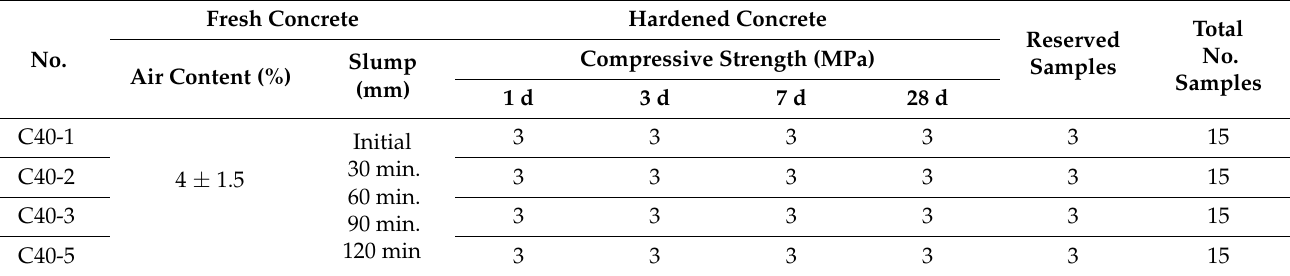
Table 8. Test method and concrete